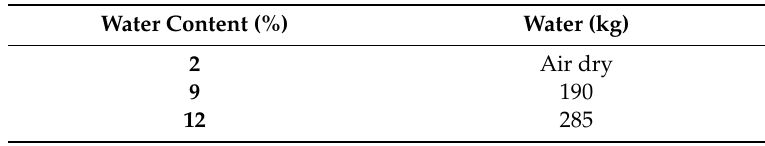
Table 5. Amount of water content.